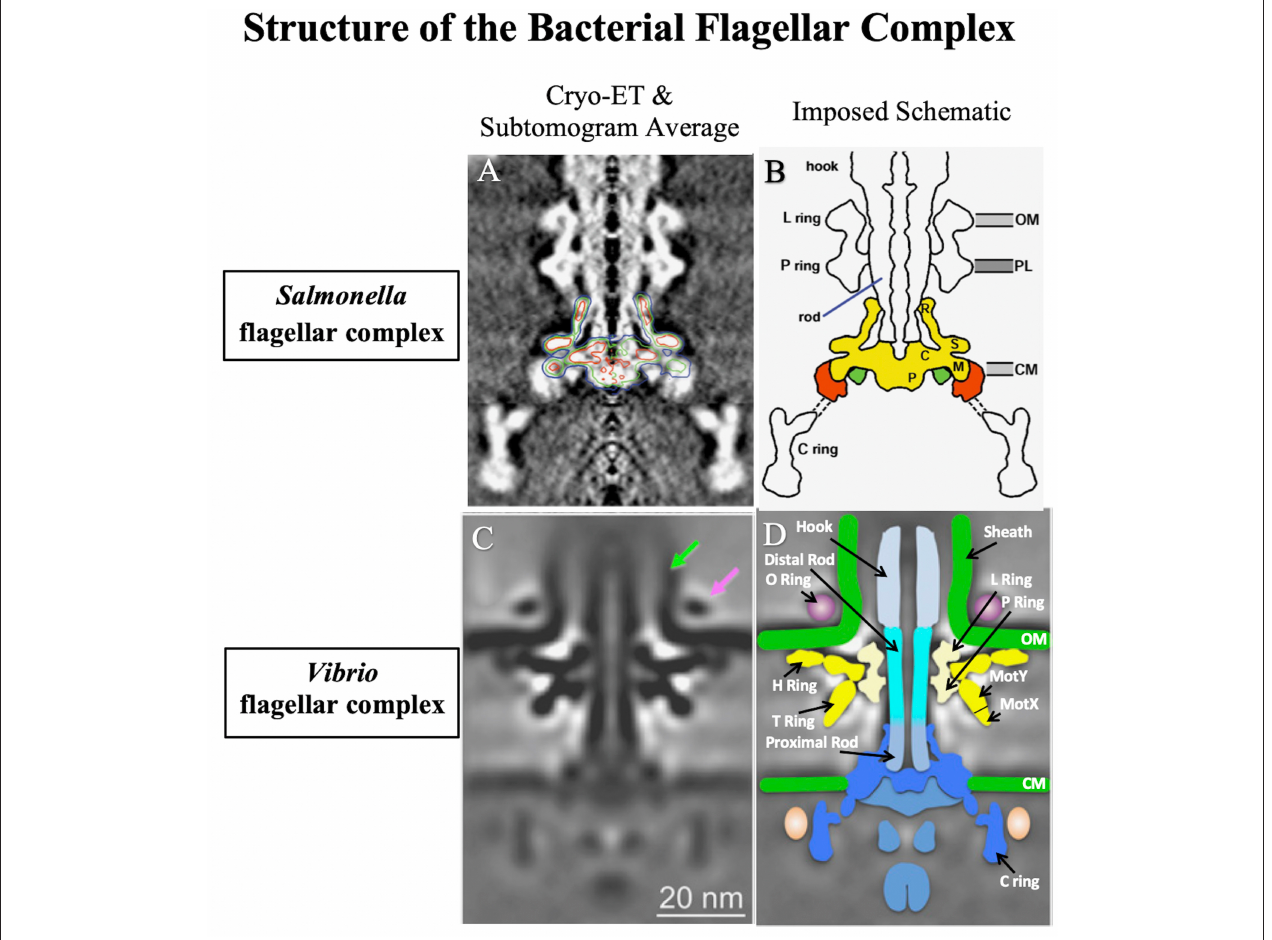
FIGURE 1 | A comparison of the well-studied Salmonella enterica serovar Typhimurium flagellar complex (Suzuki et al., 2004) to that of Vibrio alginolyticus (Zhu et al., 2017). The flagellar complex was imaged using cryoelectron tomography (Cryo-ET) combined with genetic subtomogram analysis. Final reconstructed images were generated via superimposed density maps. (A) Electron microscopy rendering of the S. Typhimurium flagellar complex with the basal body outlined. (B) Schematic of the S. Typhimurium flagellar complex. (C) Electron microscopy rendering of the sheathed V. alginolyticus flagellar complex. Vibrio specific attributes are depicted by arrows: the sheath (green arrow) and the O ring (purple arrow). (D) Schematic of the sheathed V. alginolyticus flagellar complex. Images reproduced and modified with